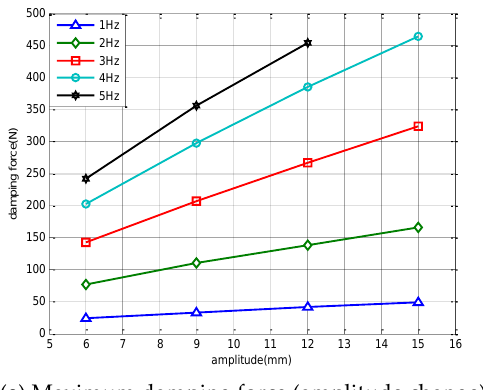
Figure 6. Maximum damping force change.